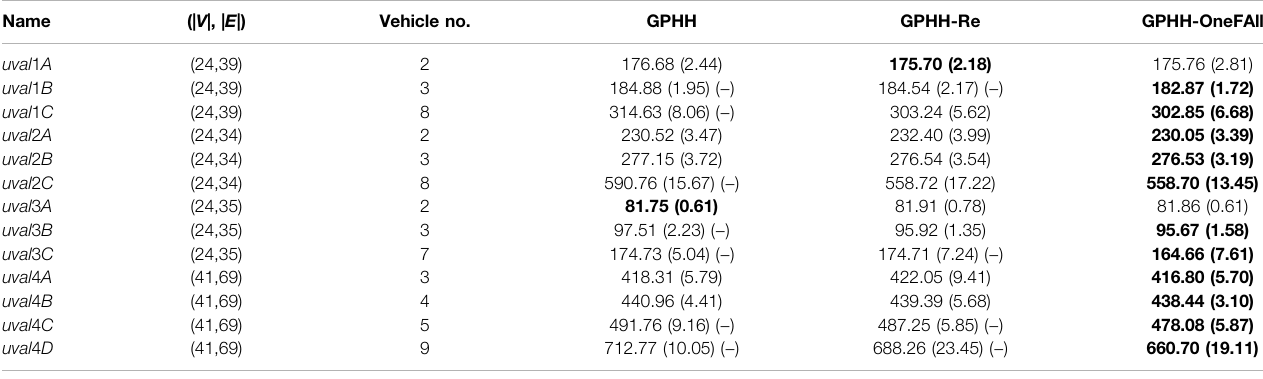
TABLE 4 | Results on the uval dataset in terms of the average on the test set.